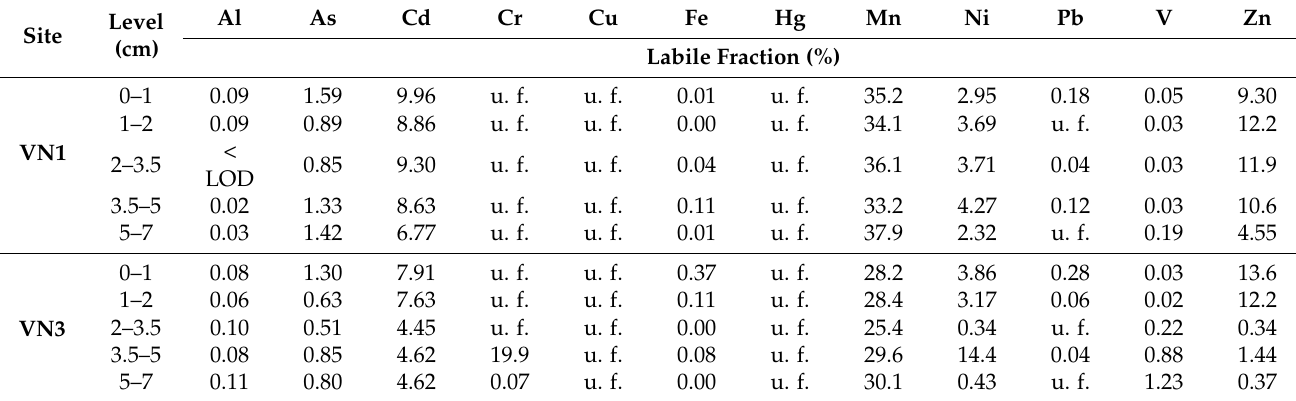
Table 2. Labile fraction (expressed in %) of metal(loid)s in sediments at sites VN1 and VN3. The abbreviation “u. f.” means unavailable form and “LOD” means limit of